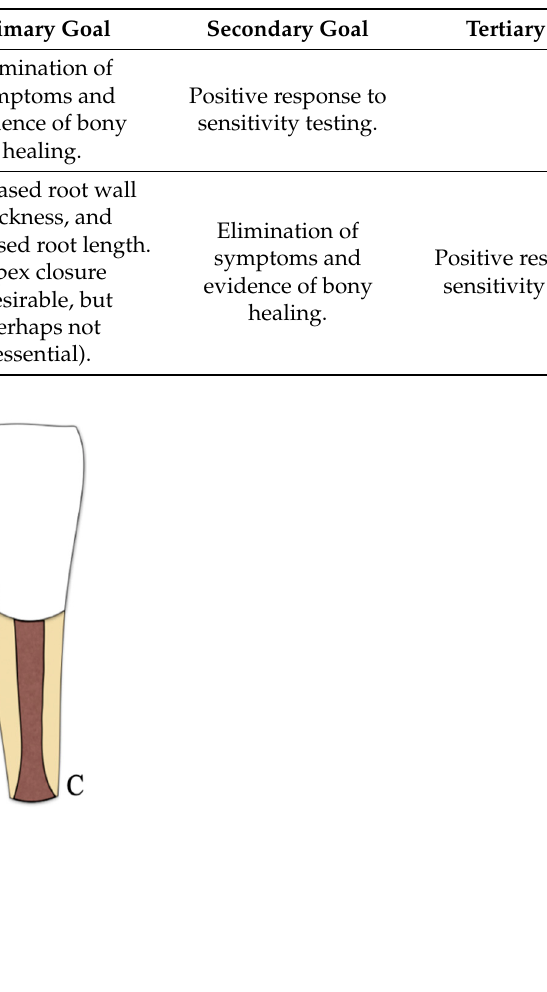
Table 3. Outcomes evaluated in the articles included in the study, depending on the development of the treated tooth.